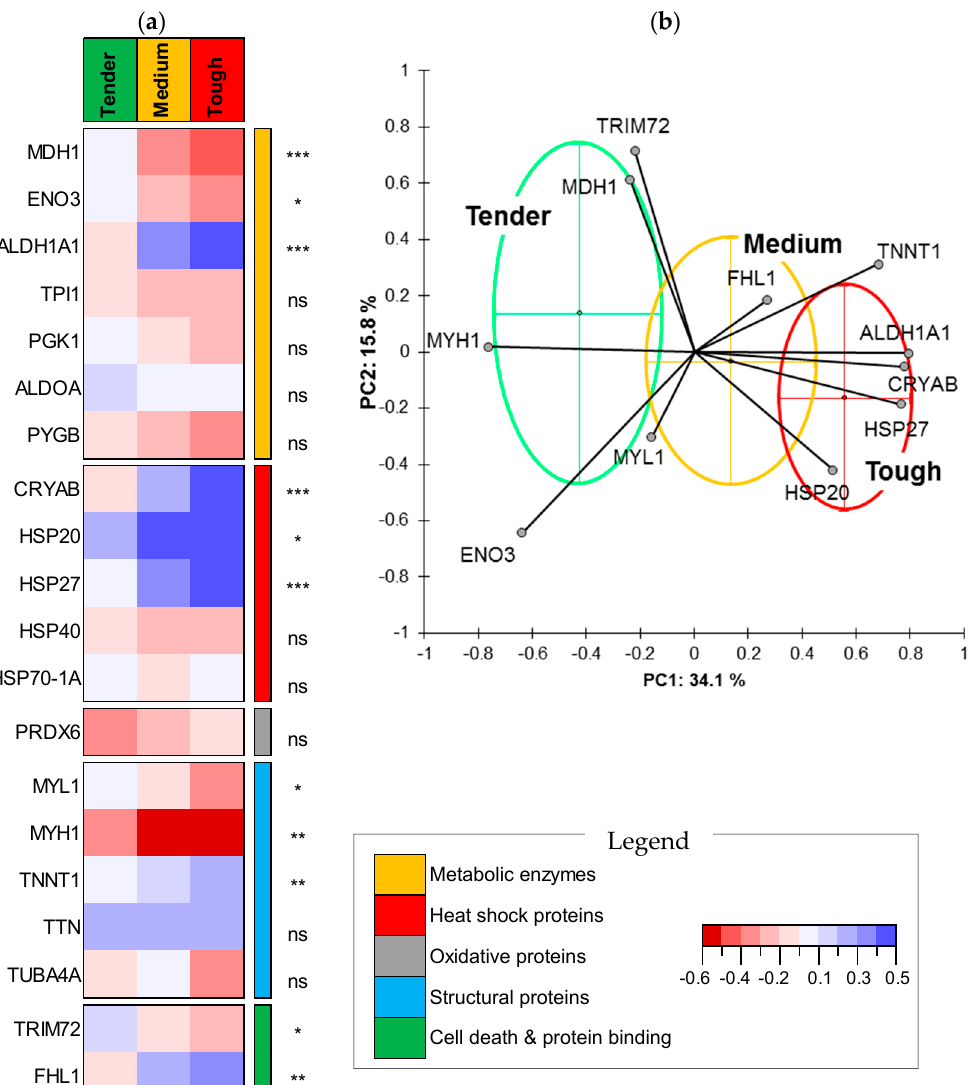
Figure 1. Protein biomarkers differing among the tenderness classes (Tender ( n = 93), Medium ( n = 71) and Tough ( n = 24)). ( a ) Heatmap comparing the protein abundances among the three WBSF (tenderness) classes. Significance—ns: not significant; *: p < 0.05; **: p < 0.01; ***: p < 0.001. The proteins are given by their biological family following the legend. ( b ) Principal component analysis highlighting the distribution of the individuals of each tenderness class based on the 11 discriminant protein biomarkers. Individuals belonging to the same class are encircled in clusters using the corresponding schematic colors. The descriptive statistics of the three tenderness classes are as follows— Tender class: mean value of 32.96 ± 3.99 N / cm 2 (CV, 12%), Min = 23.05 and Max = 38.76 N / cm 2 . Medium class: mean value of 44.74 ± 3.69 N / cm 2 (CV, 8%), Min = 39.00 and Max = 52.22 N / cm 2 . Tough class: mean value of 61.18 ± 7.87 N / cm 2 (CV, 13%), Min = 53.03 and Max = 81.49 N / cm 2